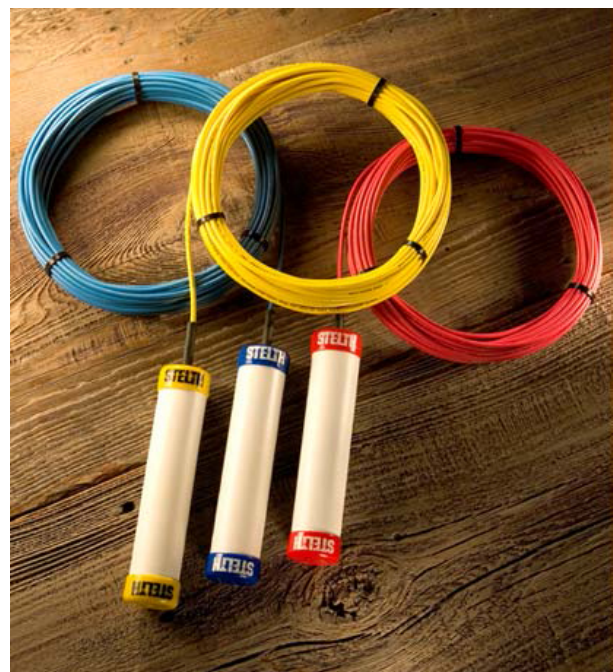
Figure 2. The Borin Stelth ® electrodes used for geoelectric moni- toring at the Boulder